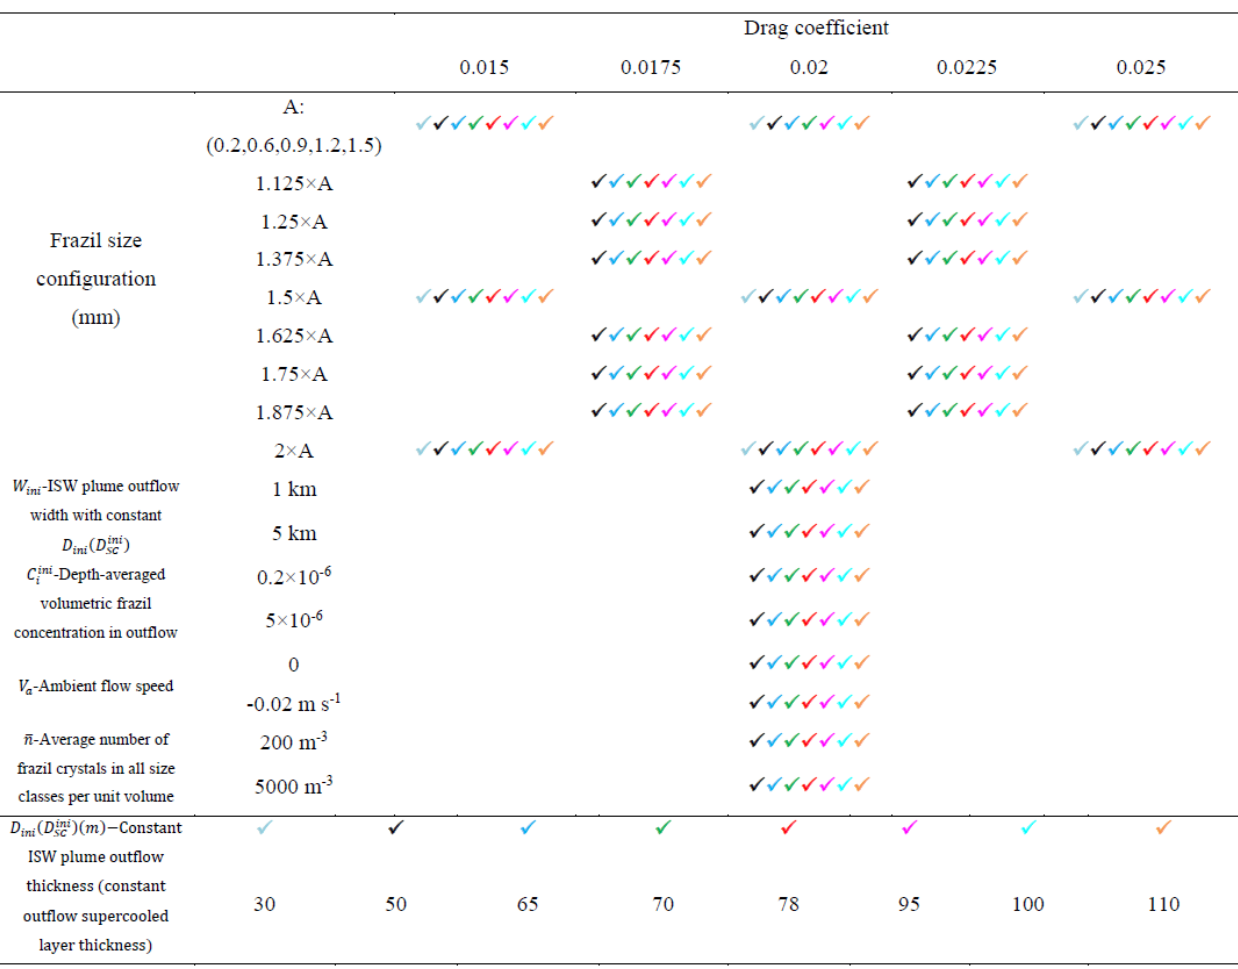
Table 3. Parameter settings for sensitivity runs, indicated by a tick and colour-coded by ISW outflow thickness (bottom row). All other parameters remain as they were for the standard model